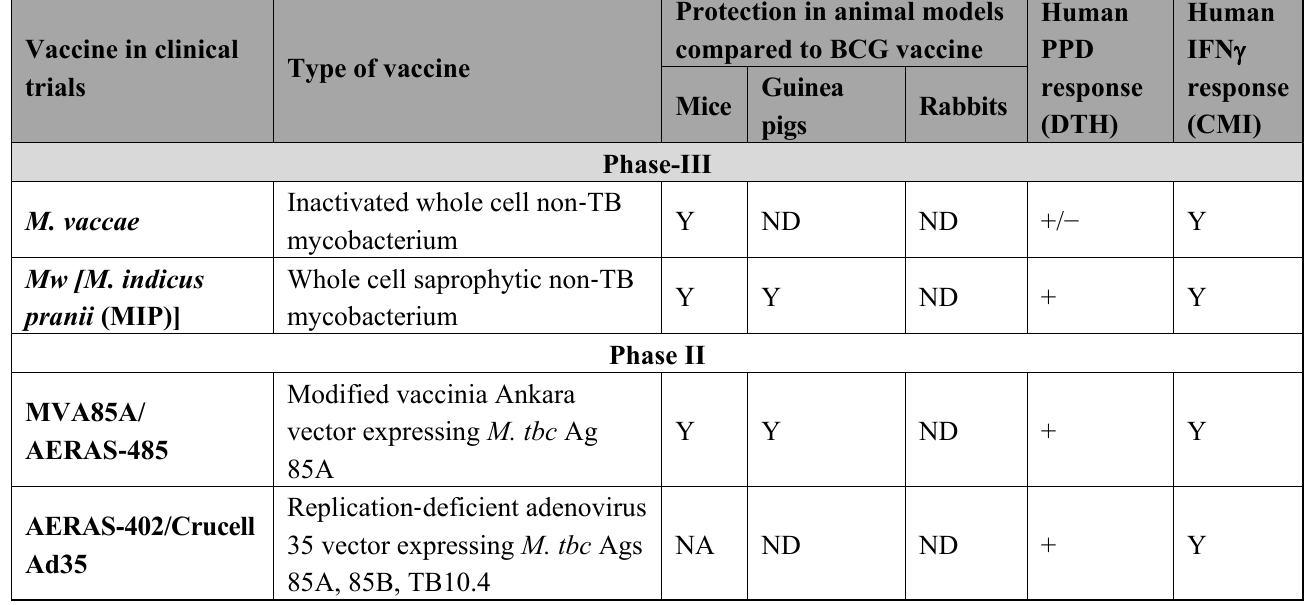
Table 1. Protective efficacy, delayed-type hypersensitivity (DTH) response and